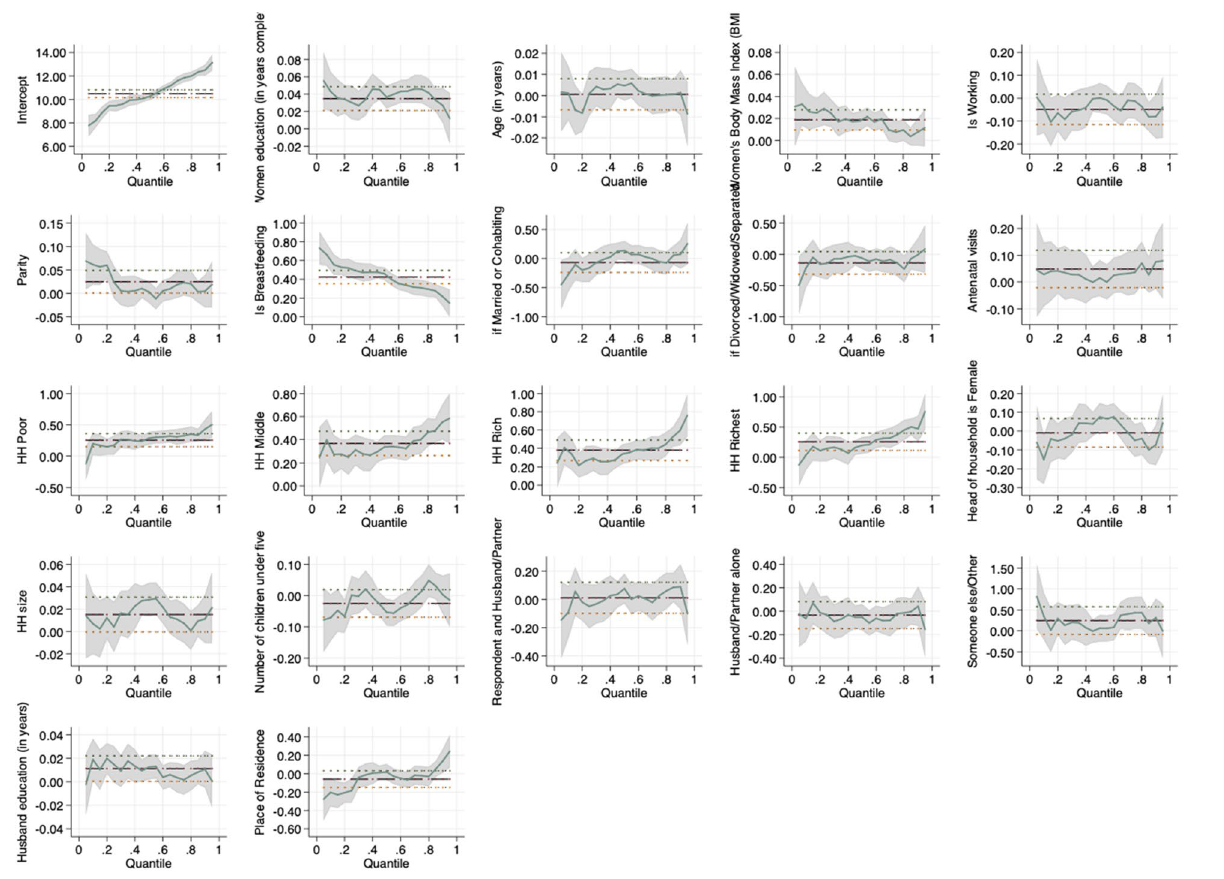
Figure 3. Pictorial presentation of the effects of socio-demographic factors on maternal Hb concentration in